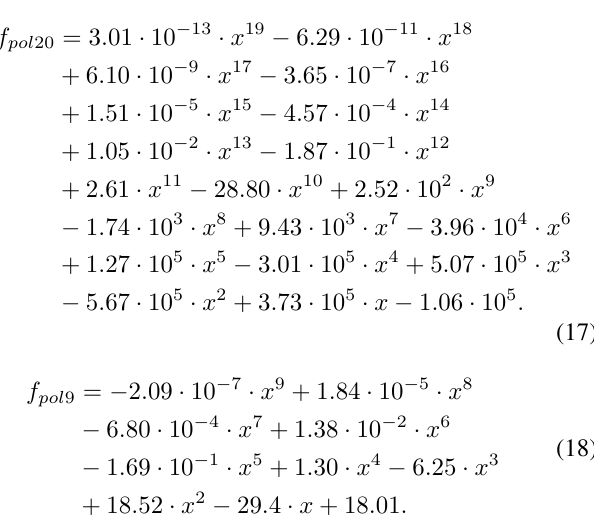
Fig. 5 illustrates the experimental and optimized curves by the proposed method and by the polynomials in (17) and